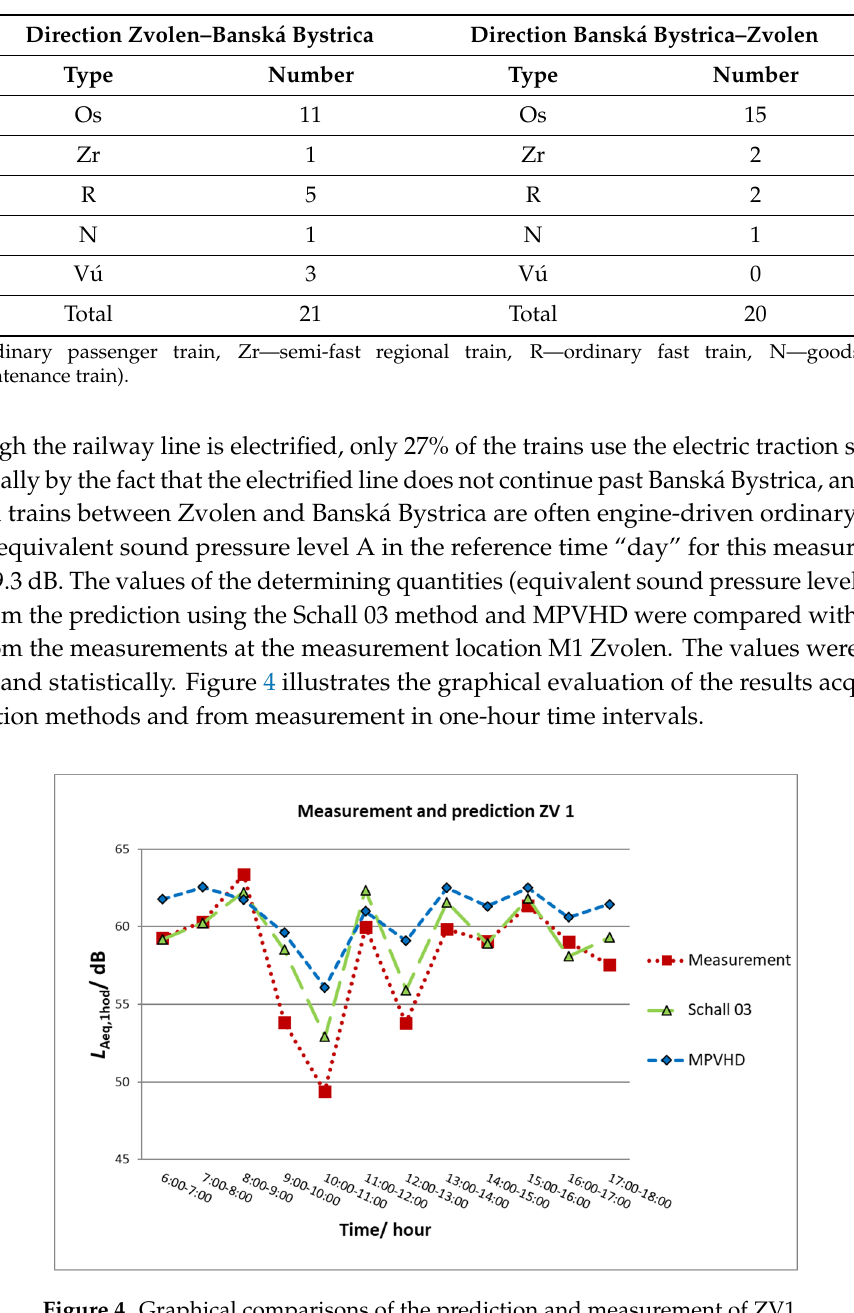
Table 1. Number and types of trains during the measurement of ZV1.